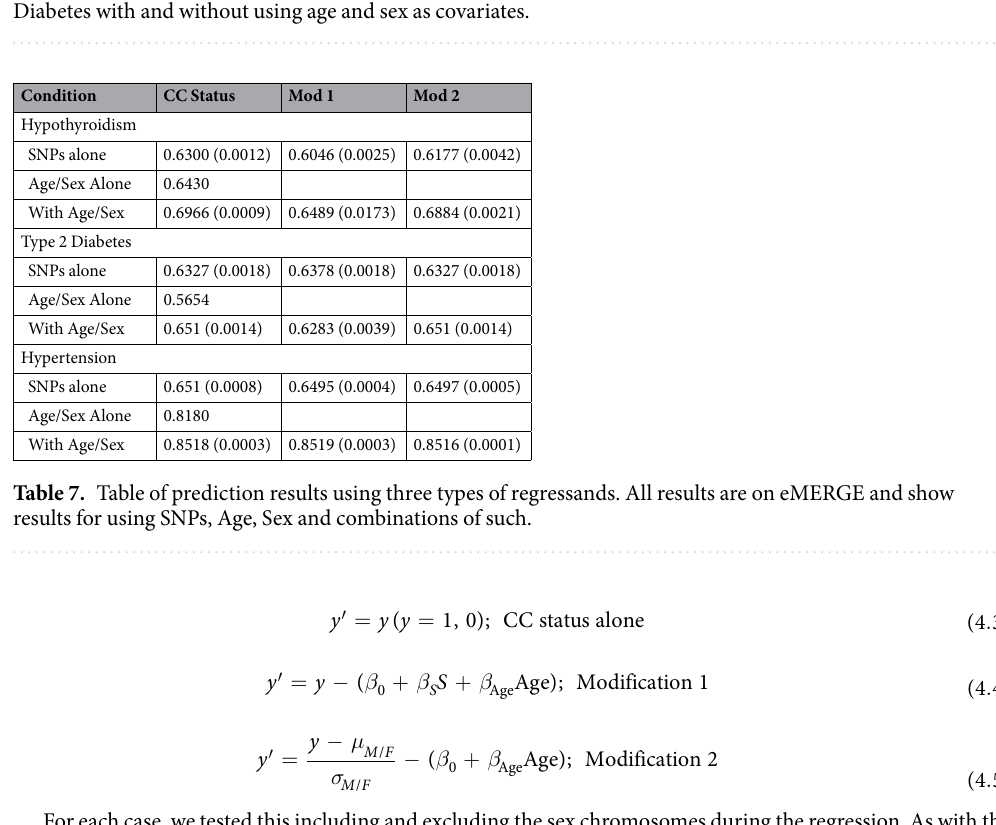
Figure 12. Odds ratio between upper percentile in PGS and total population prevalence in eMERGE for Type 2 Diabetes with and without using age and sex as covariates.